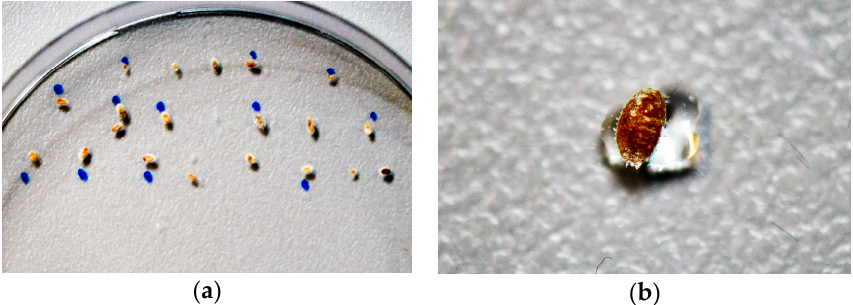
Figure 2. ( a ) Petri dish containing one test group of 20 mealybugs, each placed on one droplet (2 μ L) of test liquid CAW; ( b ) Close ‐ up of ( a ) single mealybug transferred to a test liquid droplet of PTW placed in a petri dish (droplet volume = 2 μ L).